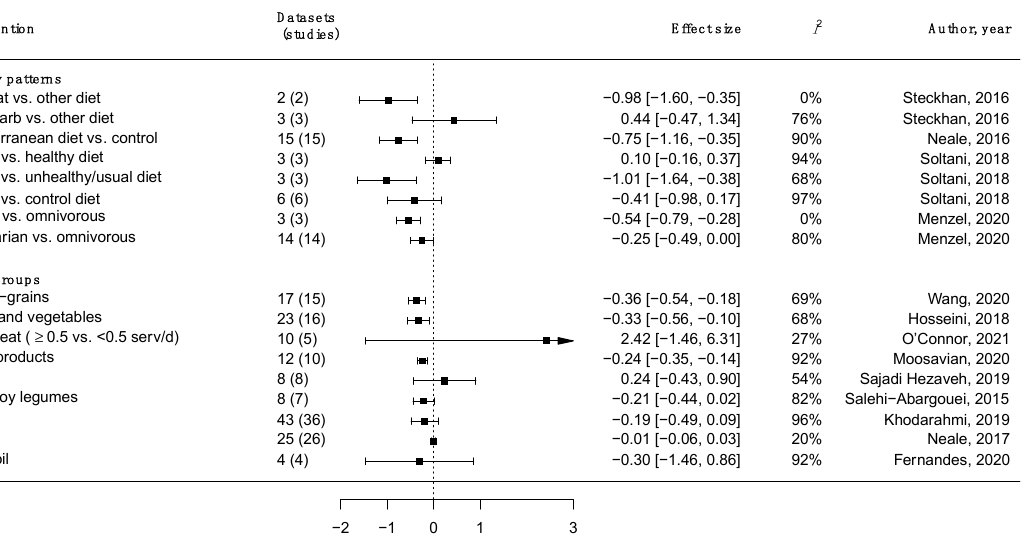
Figure 1. Summary results from meta-analyses on C-reactive protein levels changes in dietary intervention trials.